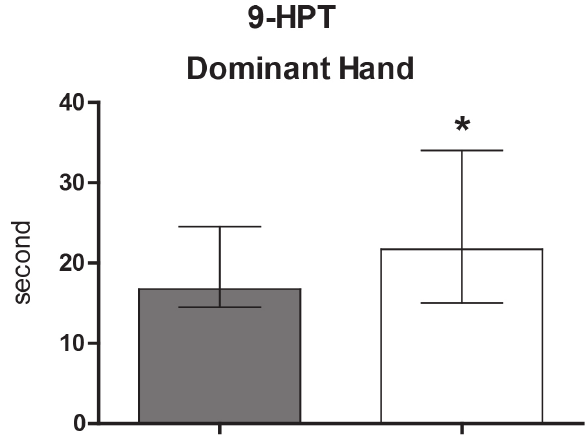
Figure 2 - 9-Hole Peg Test for the MS and control groups. Values represented in median with interquartile range (P25 - P75). *repre- sents a significant difference from the control group (Mann-Whitney test, P < .05 n =